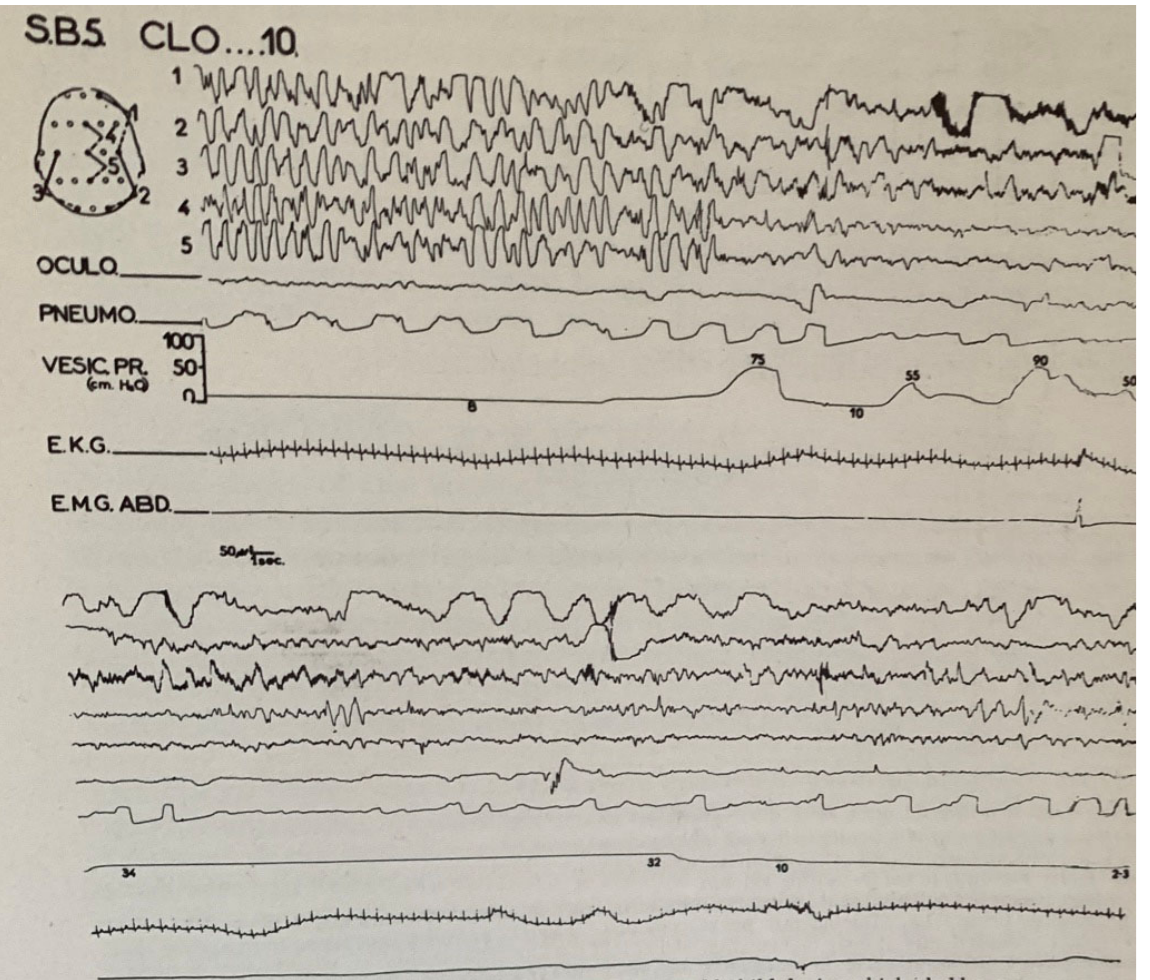
Figure 4. Enuretic episode with intra ‐ vesicular pressure recording. The episode begins in slow ‐ wave sleep and shows large waves of increased bladder pressure reaching a maximum of 90 cm water pressure. As the episode continues the urine flows out around the catheter and the intra ‐ vesicular pressure plateaus around 30 cm pressure and then decreases to 2–3 cm pressure, at which time the bladder has fully emptied. (Adapted from Gastaut, H. and Broughton, R.: A clinical and polygraphic